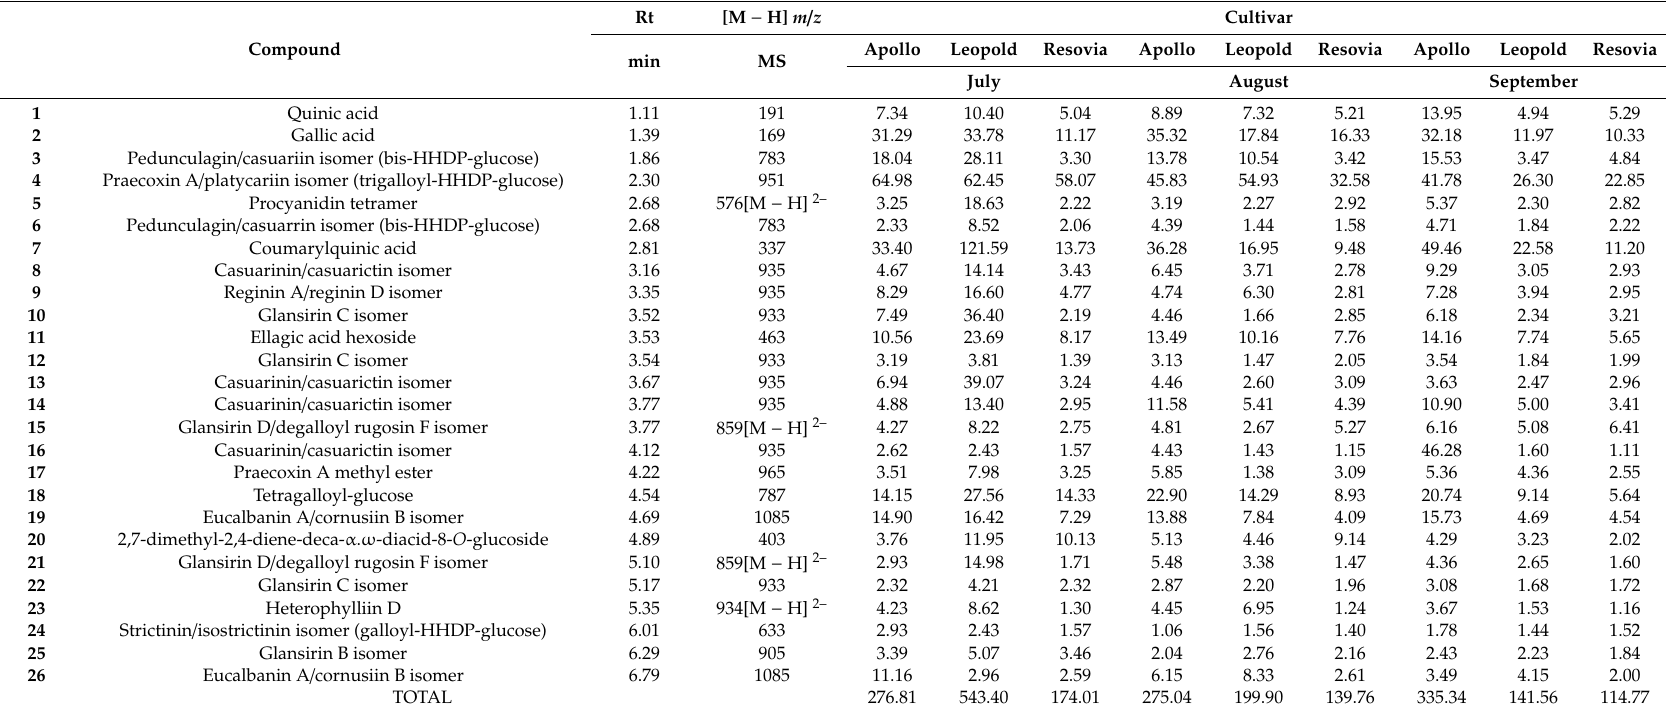
Table 4. Quantitative composition of polyphenols identified in walnuts ( µ g /